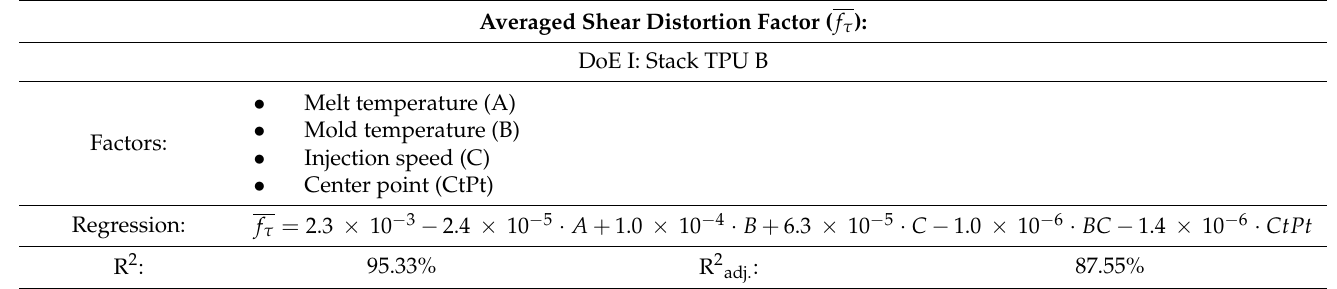
Table 7. Regression values of DoEs I, II and III for the shear distortion factors ( f τ ). Averaged Shear Distortion Factor ( f τ